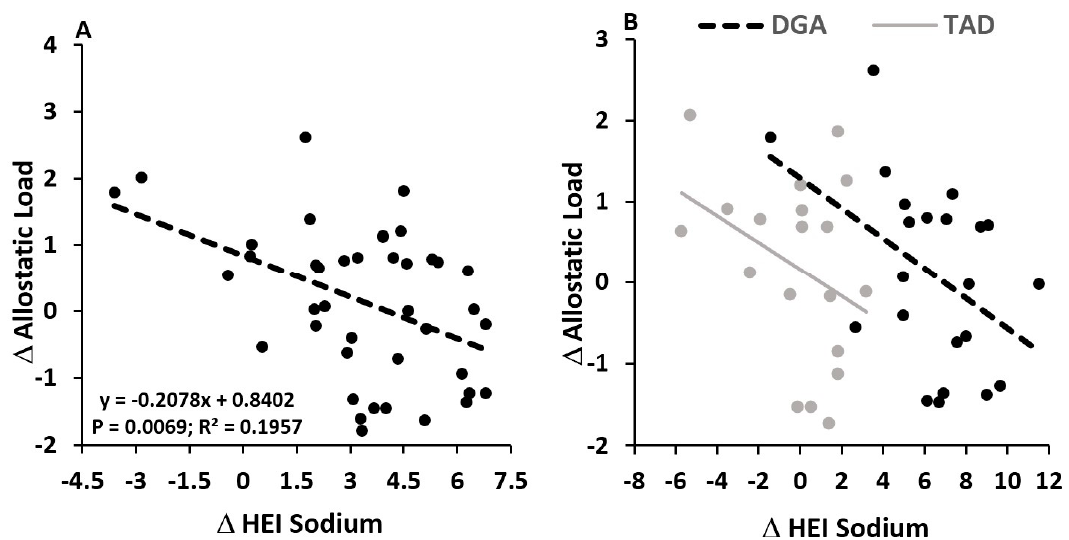
Figure 2. Independent of diet group, increasing the healthy eating index (HEI) for sodium consumption associated with reductions in the 8 week allostatic load ( A ). In the right hand figure ( B ), data and regression lines are presented for each diet group (DGA vs. TAD), showing that, for a given magnitude of delta HEI sodium, the DGA group had a higher magnitude of allostatic load change. No statistical interaction between diet group and change in HEI sodium was observed ( p = 0.7909), suggesting that regression slopes between DGA and TAD groups were not different, with both demonstrating an inverse association between delta HEI sodium and delta allostatic load. Data and regression lines presented in A and B were statistically adjusted for age, education, BMI, and pre-intervention allostatic load.